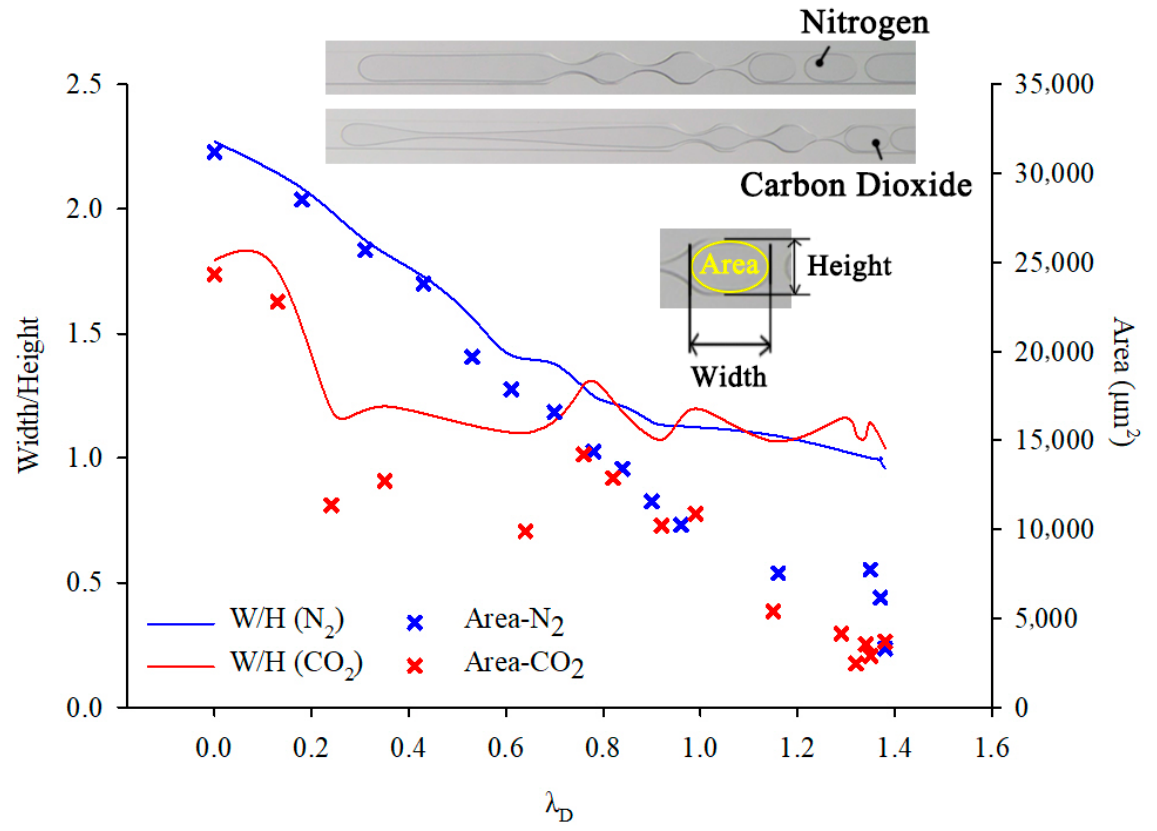
Figure 9. Gas Bubble Measurement.